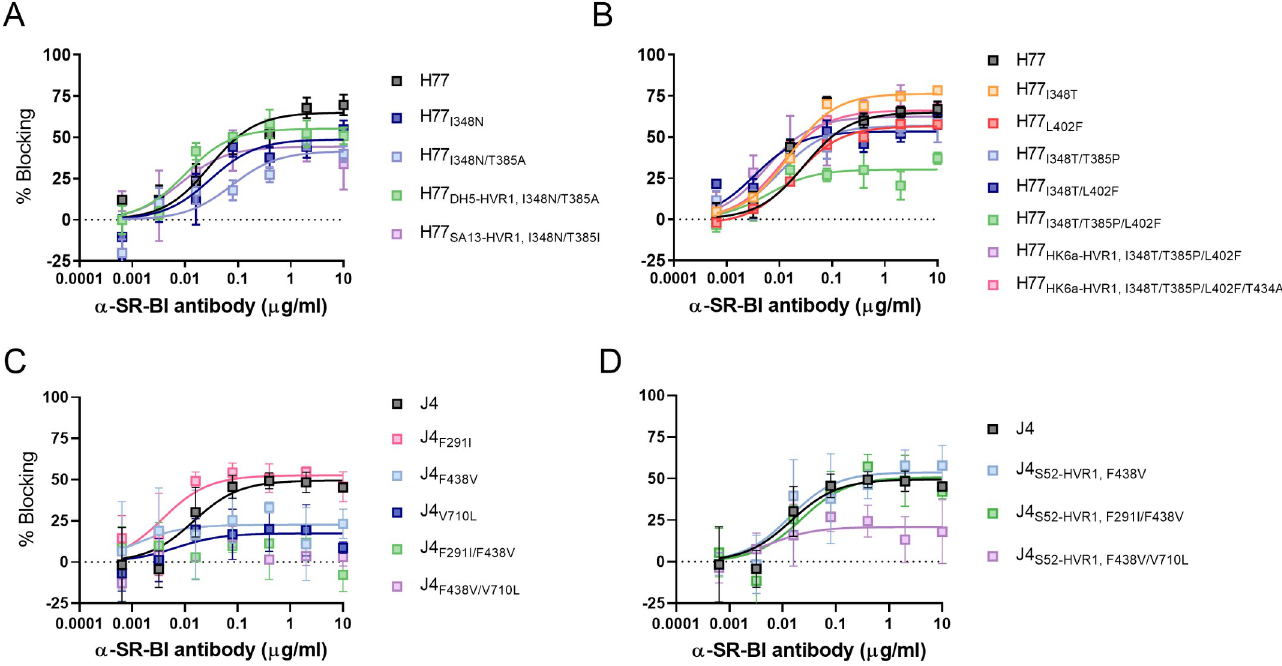
Fig 12. HVR1-swap compensatory E1/E2 substitutions typically decrease virus entry dependency on SR-BI. HVR1-swap adaptive substitutions effect on H77 (A and B) or J4 (C and D) dependency on SR-BI. Huh7.5 cells were incubated with a 5-fold dilution series of anti-SR-BI mAb, C16-71, which specifically blocks the interaction between HCV and SR-BI in four technical replicates with eight technical replicates of virus only and four technical replicates of control antibody D. 48 hours post-infection the cells were immunostained for HCV antigen, and the number of FFUs/well was counted and normalized to the mean count of wells with virus only. Error bars represent standard deviation. The data were analysed using three-parameter sigmoid dose-response curves using Graphpad Prism v8.0.0 with bottom constraints set to 0.